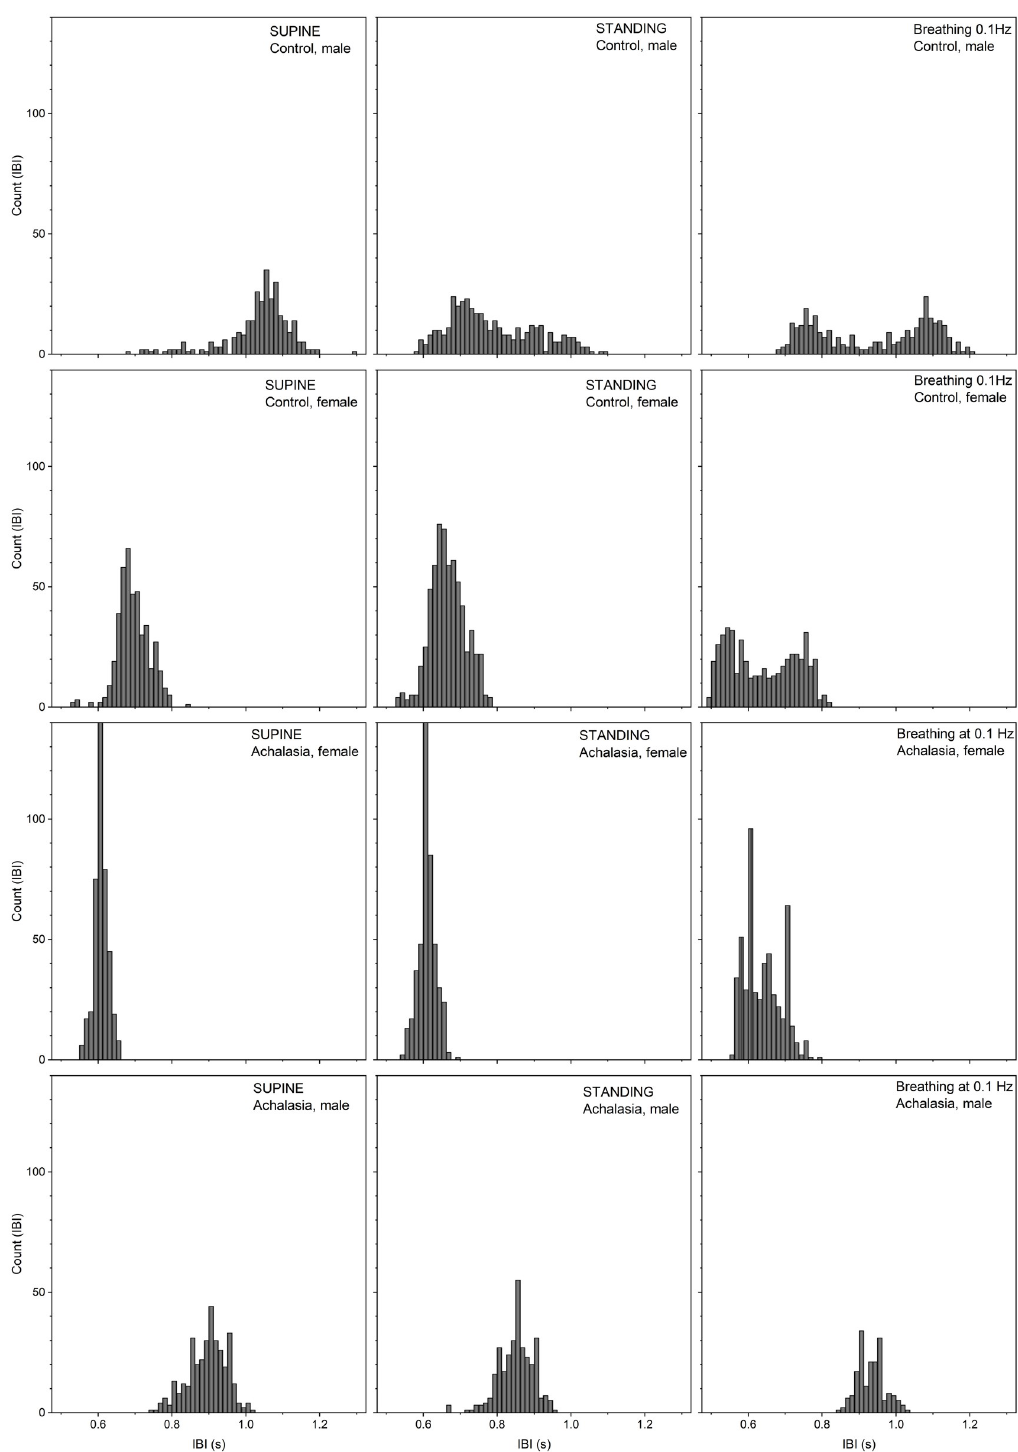
Fig 2. Histograms of IBI detrended time series for typical patients (30 years old). Male M30C01 and female F30C01 control (upper rows), female F30A01 achalasia (middle row), and male M30A01 achalasia patients (lower row) in supine position (left- hand column), standing up position (middle column), and under controlled breathing at 0.1 Hz (right-hand column).